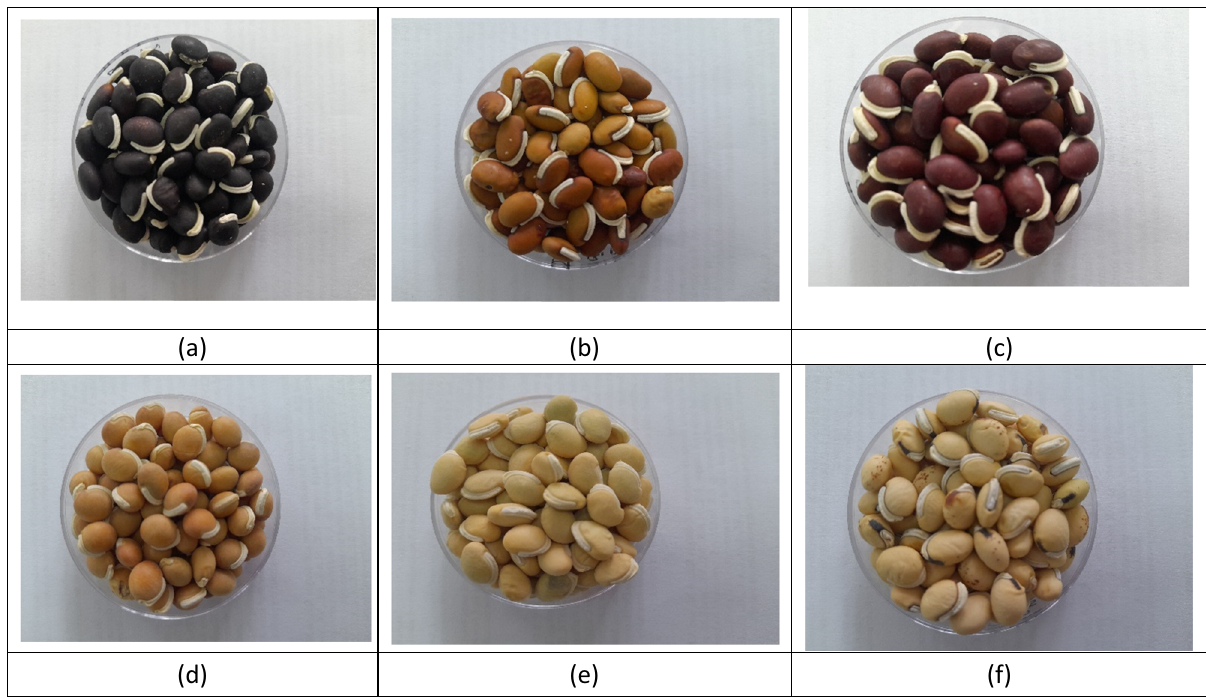
Figure 1: The common - colored seeds of the collected Lablab landraces illustrated using a polystyrene Petri - dish. ( a ) Black colored seeds, ( b ) brown colored seeds, ( c ) red colored seeds, ( d ) cream colored seeds, ( e ) white colored seeds, and ( f ) white colored seeds with black hilum ( eye ) edges ( diameter of the Petri - dish: 65 mm × 15 mm ) .